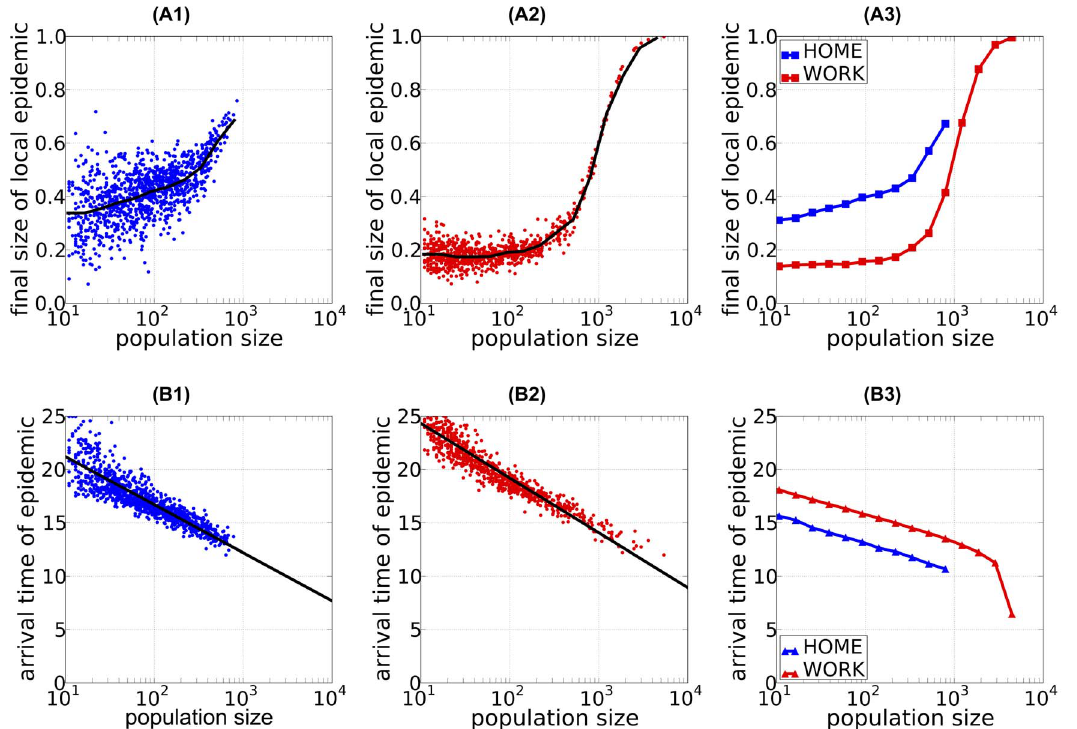
Figure 6. The final size of epidemic and the arrival time of epidemic at local populations. The final size of the local epidemic (A) and the time until the infected individuals first appear in the local population (B) (i.e., the arrival time of epidemic) plotted against the local population size. The population size is on a logarithmic scale. (A1–2) and (B1–2): results of the individual-based model (IBM) simulations; each point (dots) gives the mean value of the Monte Carlo ensemble averaged over 100 Monte Carlo runs for each local population, and the blue and red dots correspond to the results for the home and work populations, respectively. The black lines in (A1–2) give the mean value of the final size of the local epidemic for each population size class. The black lines in (B1–2) represent the regression line of the arrival time of the epidemic in the local population versus the ~ a H { b H ln N H in the i -th home population with population size N H , t H , logarithm of the population size. The regression line for the arrival time t H i i i i was highly significant, with a P-value of v 10 { 3 F test ( F ~ 2706 with the degrees of freedom (1, 1084)), R 2 ~ 0 : 741 . The estimated intercept a H and slope b H and their 95 % confidence intervals (CIs) are a H ~ 25 : 99 + 0 : 34 ( 95 % CI) and b H ~ 2 : 01 + 0 : 08 ( 95 % CI). The same was true for the ~ a W { b W ln N W was highly significant ( P v 10 { 3 , F ~ 2704 with df ~ (1,1833) ), with arrival times in the work population; the regression t W j j estimated intercept and slope a W ~ 29 : 67 + 0 : 27 ( 95 % CI) and b W ~ 2 : 27 + 0 : 06 ( 95 % CI), respectively. (A3) and (B3): corresponding results obtained from the population size class model (PSCM); the blue line shows the result for the home population and the red line the result for the work population (refer main text for details). The infection rate was b ~ 4 : 6 | 10 { 4 . A person commuting from ‘‘Gyotoku’’ station to ‘‘Aoyama-itchome’’ station was designated the initially infectious